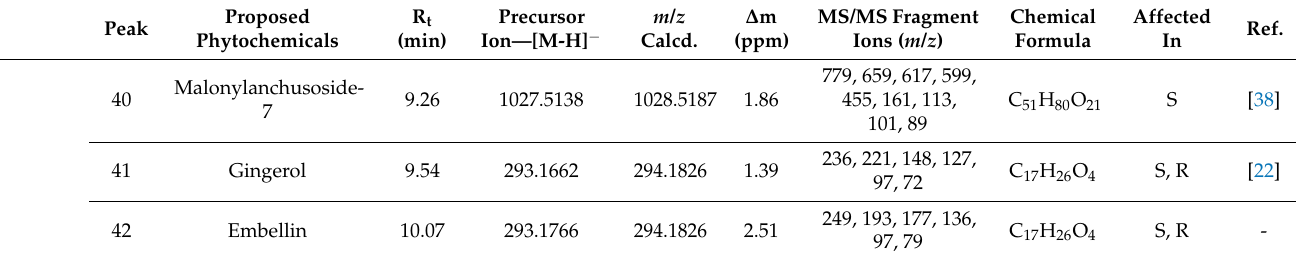
Table 2. Affected primary ( a ) and secondary metabolites ( b ) in root and shoot samples of Anchusa officinalis associated to R. irregularis MUCL 41883, R. intraradices MUCL 49410, R. clarus MUCL 46238 and R. aggregatus MUCL 49408 growing for 9 days in the semi-hydroponic cultivation system.